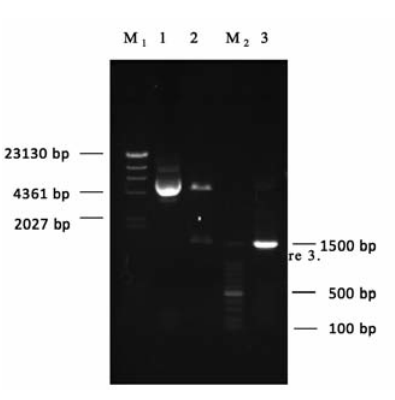
Figure 3. Agarose gel electrophoresis of plasmid PCR and the digest product of the pGEX-MCP recombinant plasmid. M : 1 DNA marker ( λ -Hind III digest marker); line1: pGEX-MCP recombinant plasmid; line 2: pGEX-MCP/ EcoR I+ Not I ; M : 2 Gene RuLer TM 100 bp DNA ladder marker; line 3: PCR products